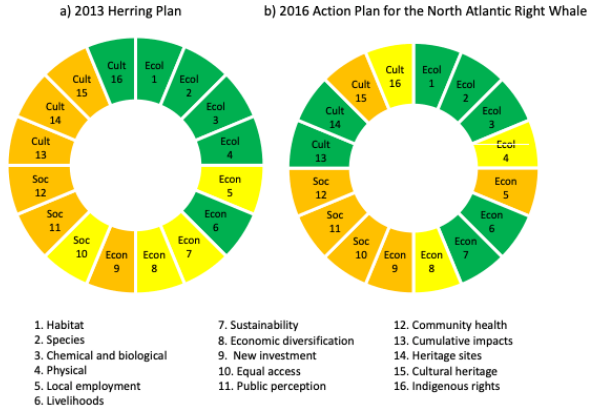
Fig. 1 . Comparison of two management plans evaluated with the Community Values Criteria framework: (a) 2013 Herring Plan and (b) 2016 Action Plan for the North Atlantic Right Whale. Green scores indicate detailed mentions within the management plan, yellow scores indicate scant mention, and orange scores indicate no mention. Words within slices refer to objective category (Cult, cultural; Ecol, ecological; Econ, economic; Soc, Social), and numbers correspond to list of objectives